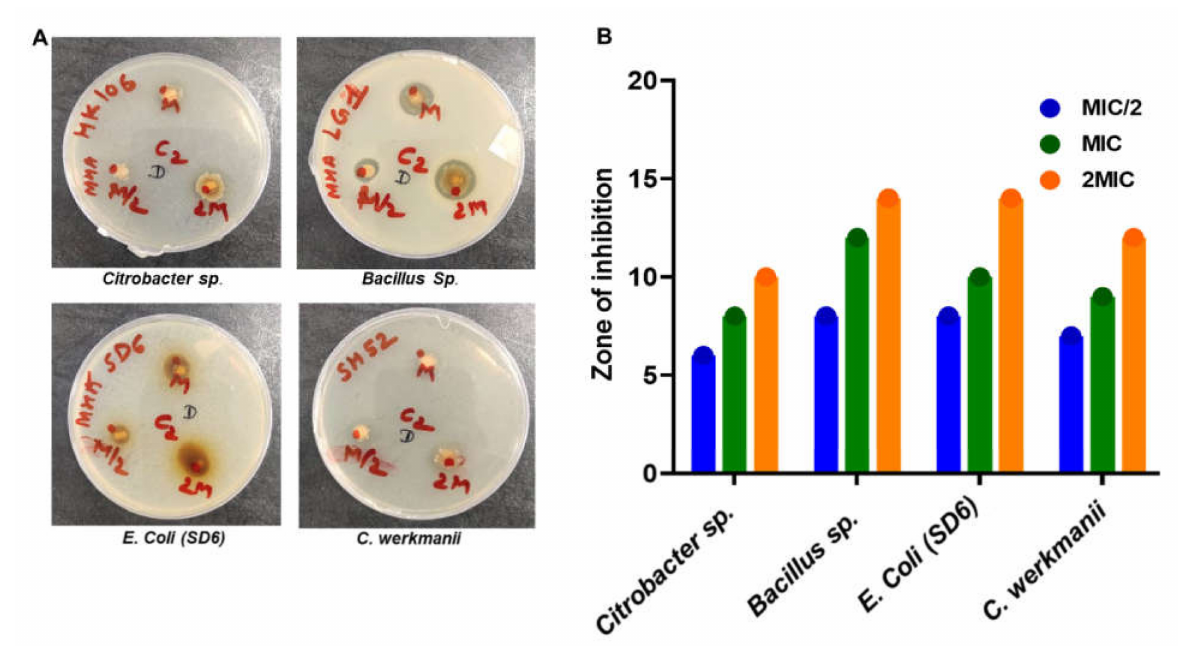
Figure 3. Zone of inhibition assay: ( A ) Representative images of culture plates showing PIP mediated growth inhibition of Citrobacter sp., Bacillus sp., E. Coli (SD6) , and C. werkmanii ; ( B ) Quantification of ZOI studies for Citrobacter sp., Bacillus sp., E. coli (SD6) , and C. werkmanii .